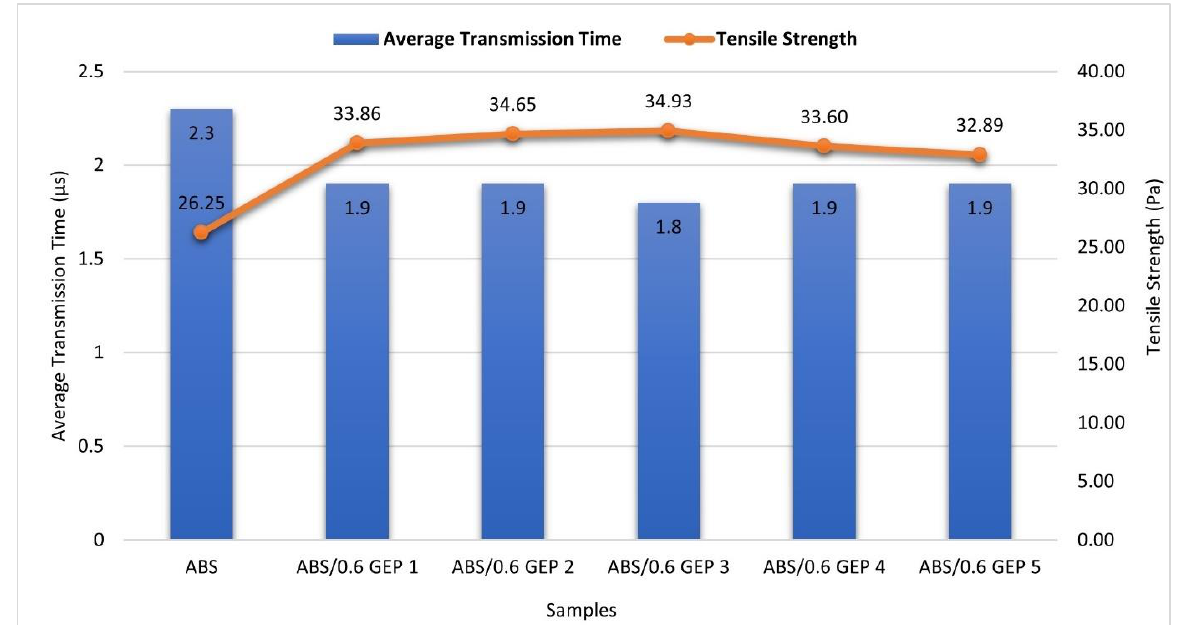
Figure 18. Correlation between average transmission times and tensile strength for ABS/0.6 GEP composites.